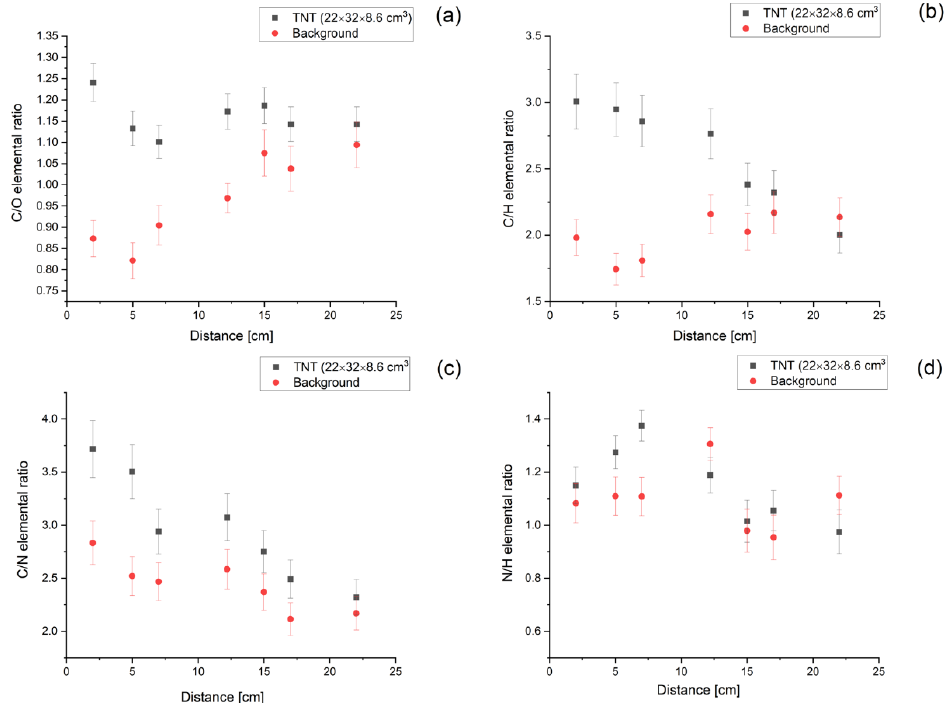
Figure 6. Elemental ratios of carbon and oxygen ( a ), carbon and hydrogen ( b ), carbon and nitrogen ( c ) and nitrogen and hydrogen ( d ), simulated for a sample of TNT (black) and background (red). In the calculations, we have taken into account the escape peaks for oxygen and carbon lines by adding their integrals to those for the original lines. These results correspond to the interrogation time of 1 s.